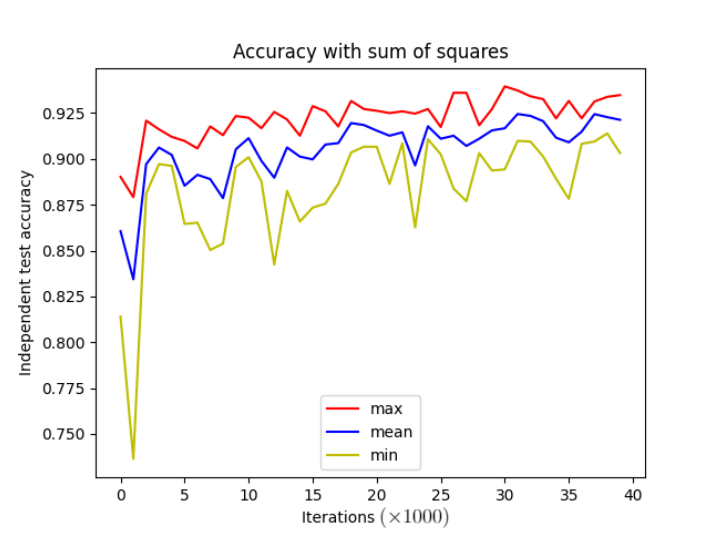
Figure 3. Five training results of HADB classification in frequency domain with the proposed nonlinear activation function, with square sum. The red color means the maximum accuracy, the yellow color is the minimum accuracy and the blue line shows the mean